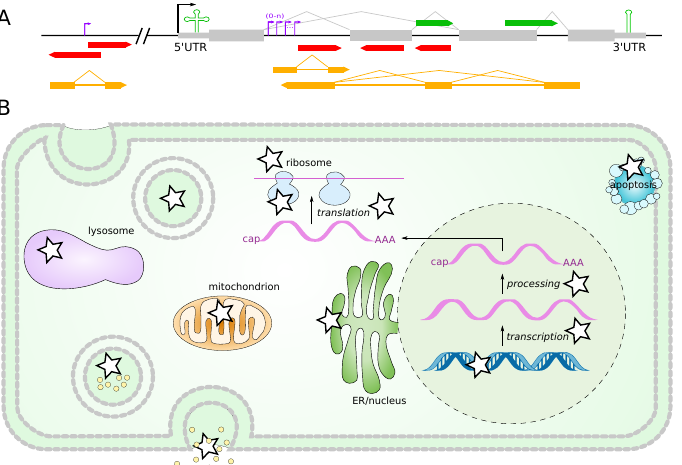
Figure 1. ( A ) Genomic locations of non-coding RNAs. NcRNAs can be located in 5 (cid:48) /3 (cid:48) UTRs and introns of proteins and are therewith transcribed with the protein (green). Additionally, ncRNAs exist sense and antisense in introns and exons of proteins and independent of proteins with own transcrip- tion start sites and promoter regions (red). Long non-coding RNAs usually span many kilobases and contain their own introns, located sense, antisense or independent of protein coding regions (yellow). ( B ) The various types of ncRNAs function in all basic cellular processes: transcription, processing, translation. They are involved in chromosome structure, DNA replication, gene regulation, genome defense and protein transport as indicated by the stars. Please note miRNA and lncRNAs are located in exosomes and